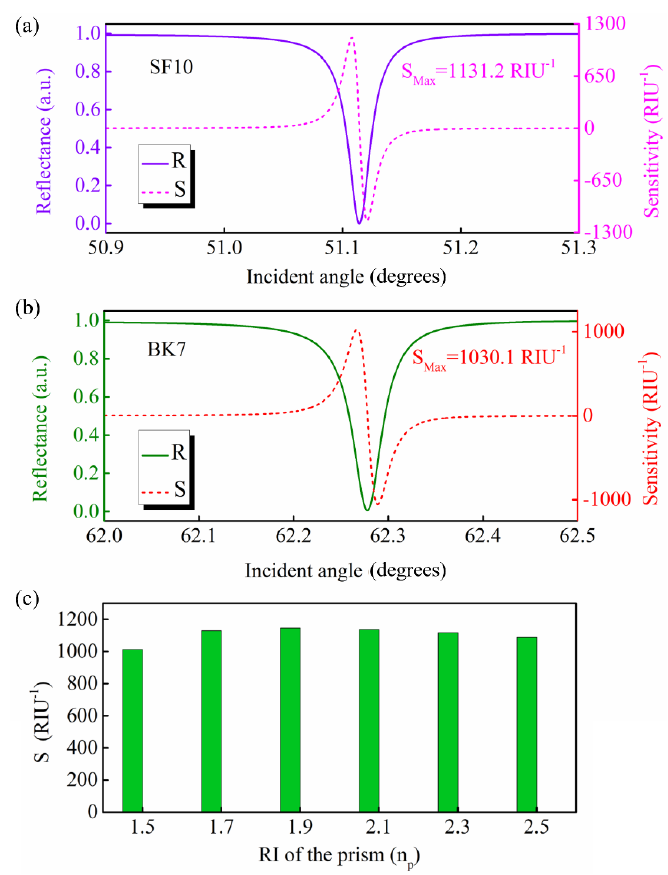
Figure 3. Reflectance and sensitivity of the proposed GW − LRSPR sensor based on ( a ) SF10 and ( b ) BK7 prisms. ( c ) The sensitivity of the proposed GW − LRSPR sensor based on different prisms.